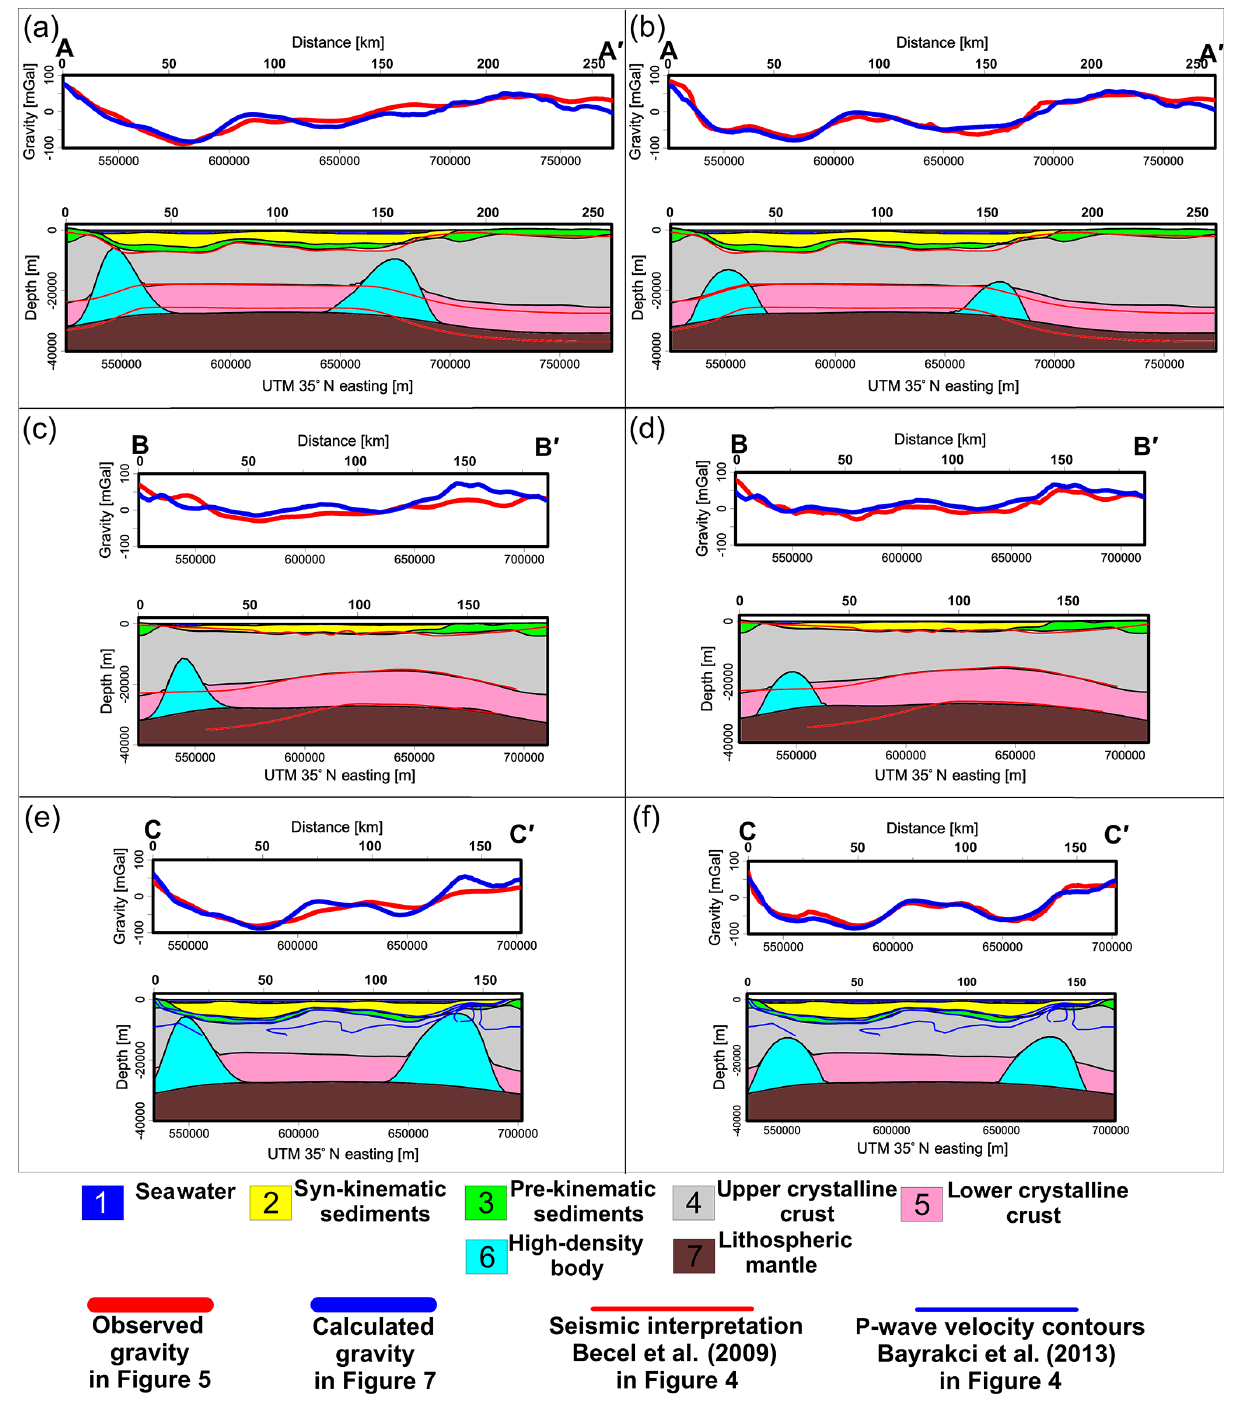
Figure 10. Cross-sections for alternative best-fit density models to the two different gravity datasets including high-density bodies, with an average density of 3150kgm − 3 (Model I and Model II) with the observed and calculated gravity and the seismic information along the AA (cid:48) , BB (cid:48) , and CC (cid:48) profiles in Fig. 4. Model I shows the best-fit gravity model to EIGEN-6C4 dataset (Förste et al., 2014) and Model II represents the best-fit gravity model to Improved-TOPEX dataset (Kende at al., 2017): (a) Model I, (b) Model II, (c) Model I, (d) Model II, (e) Model I, and (f) Model